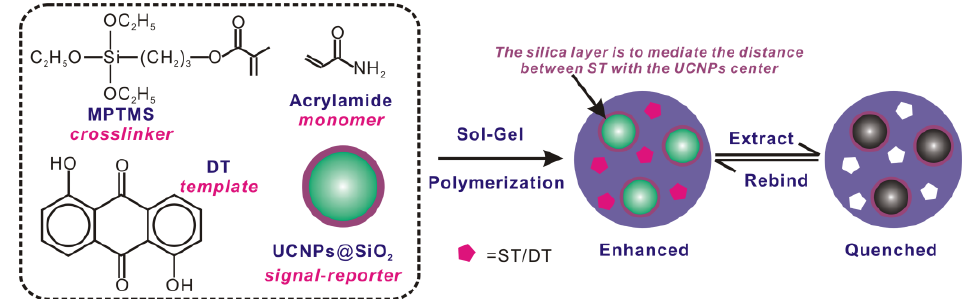
Figure 1. Schematic illustration of upconversion nanophosphor-involved molecularly imprinted fluorescent polymers for sensitive and specific recognition of sterigmatocystin.